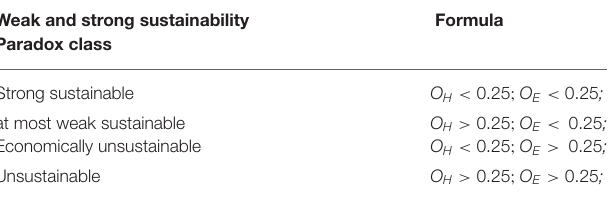
TABLE 2 | The paradigm of Weak and Strong Sustainability is calculated with the following classification concerning the use of the concepts of Overuse and